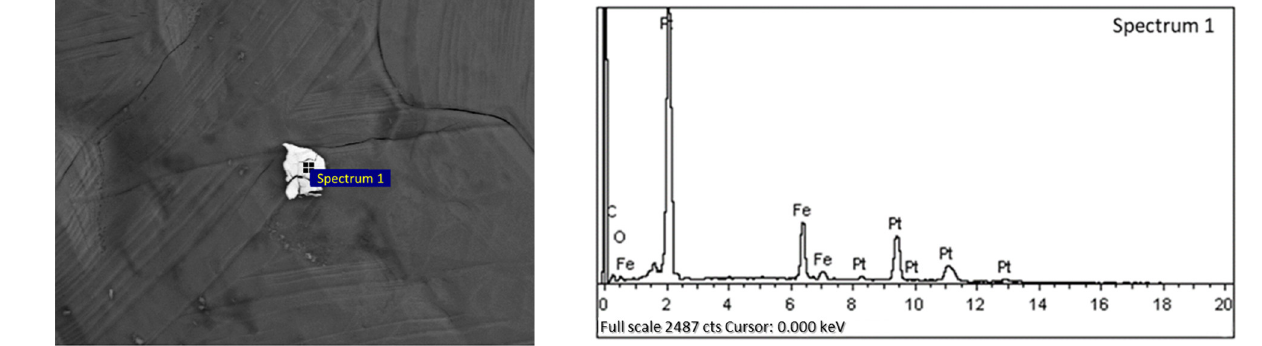
Figure 16. Tetroferroplatinum observed by scanning electron microscopy in DOS samples. Table 10. The elemental composition of the spectrum for the samples shown in Figure 16.